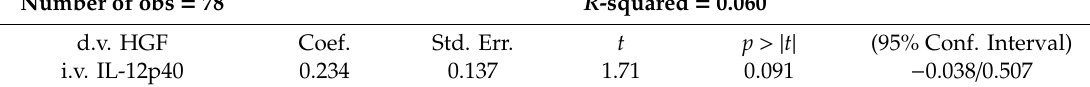
Legend to Table 5: HGF, hepatic growth factor; SLD, spleen longitudinal diameter at ultrasonography; IL-16, interleukin-16; Il-12p40, interleukin-12 subunit p40. The low R squared, in presence of both significant values, shows that even noisy, high-variability data can have a significant trend, even though data points fall further from the regression line in graph; d.v., dependent variable; i.v., independent variable. In bold are highlighted the significant ones.